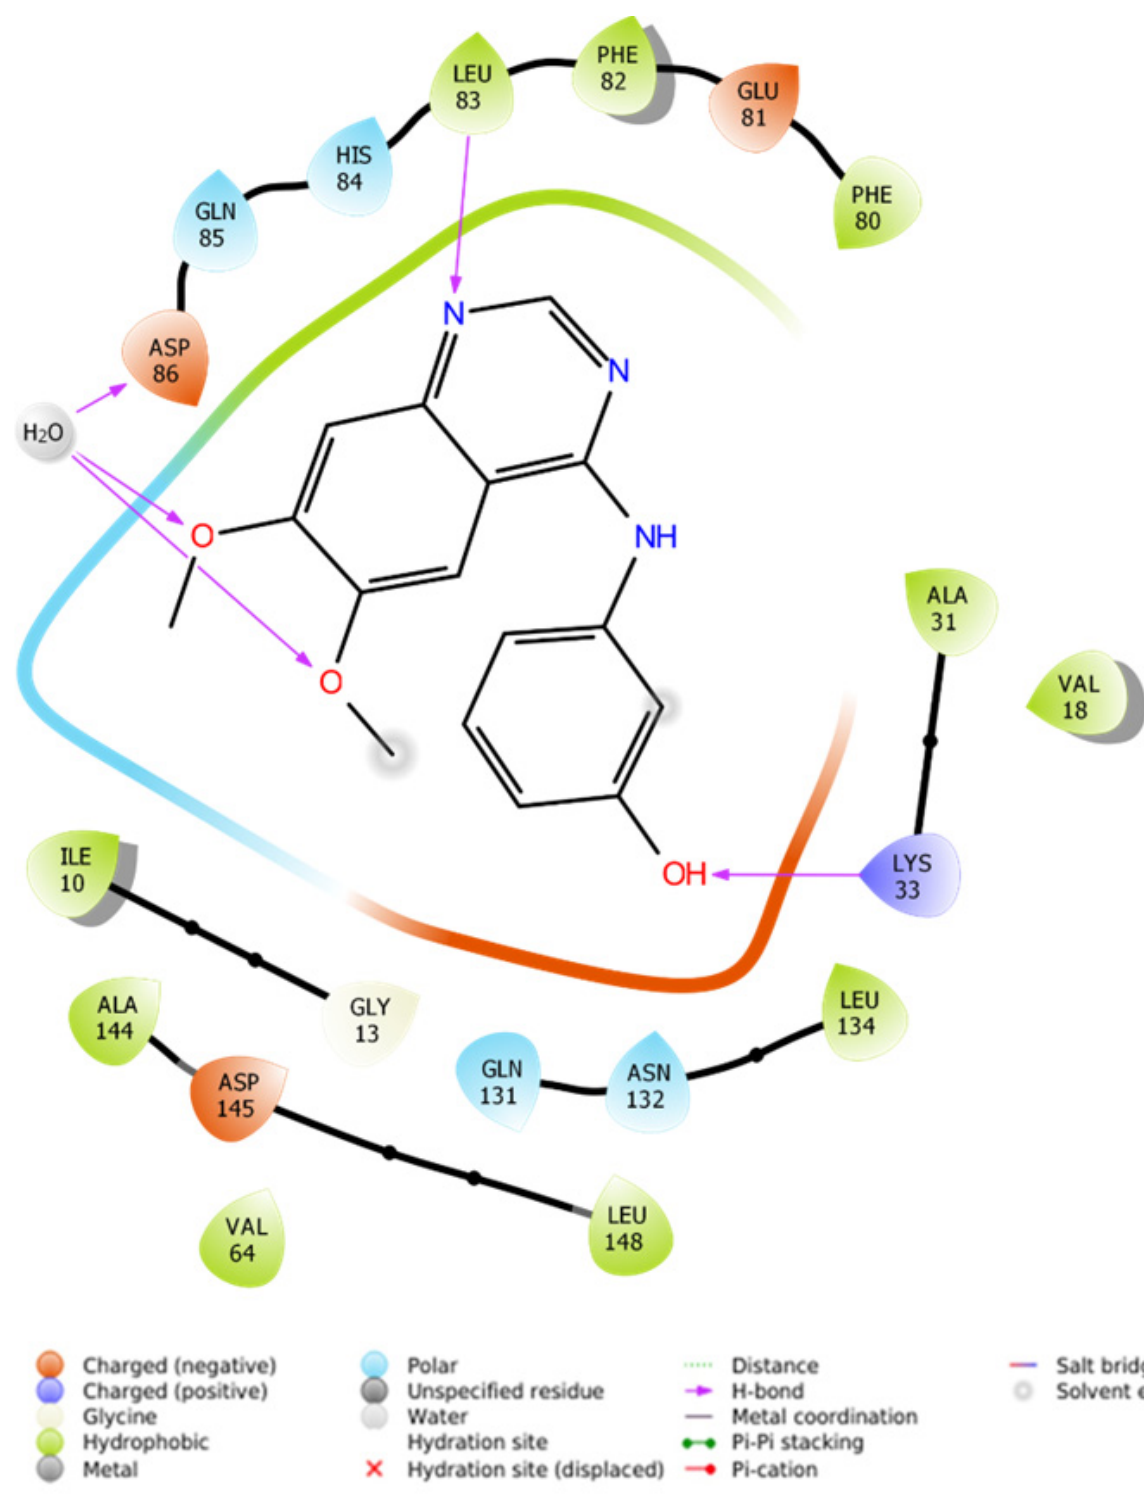
Figure 6. Two-dimensional binding interactions of DTQ within the ATP binding pocket of CDK2.